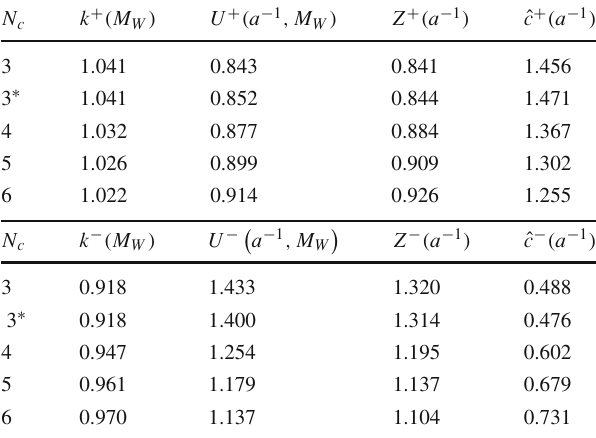
Table1 PerturbativerenormalizationconstantsandRGrunningfactors for the ensembles with N f = 4. Z σ one loop in tadpole-improved perturbation theory using the results in [43,44], whereas U σ and k σ are computed using the two-loop MS coupling. The star labels the simulation points with finer latticespacing, a ∼ 0 . 065 fm. In the evaluation of ˆ c σ 4 ) = 298 MeV from Ref.